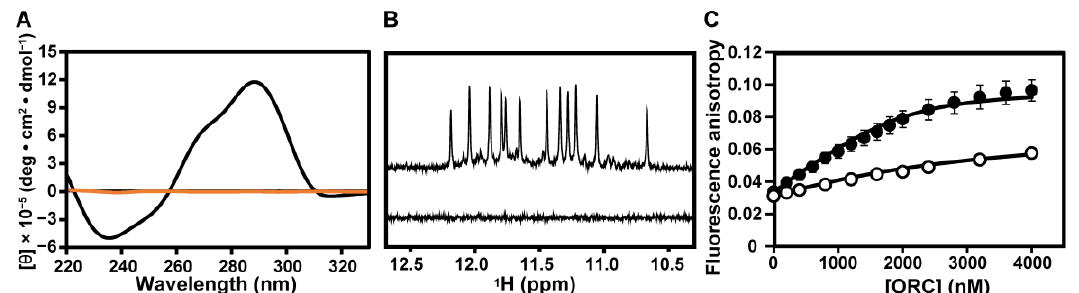
Figure 2. Effects of KCl and LiCl on the structure formation of teloDNA and binding of teloDNA to hORC1 413–511 . ( A ) CD spectra of teloDNA under 100 mM KCl (black) and 100 mM LiCl (orange) conditions. ( B ) 1 H NMR spectra of teloDNA under 100 mM KCl (top) and 100 mM LiCl (bottom) conditions. ( C ) FA titration curve of FAM-labeled teloDNA against hORC1 413–511 under 100 mM KCl (filled) and 100 mM LiCl (open) conditions.